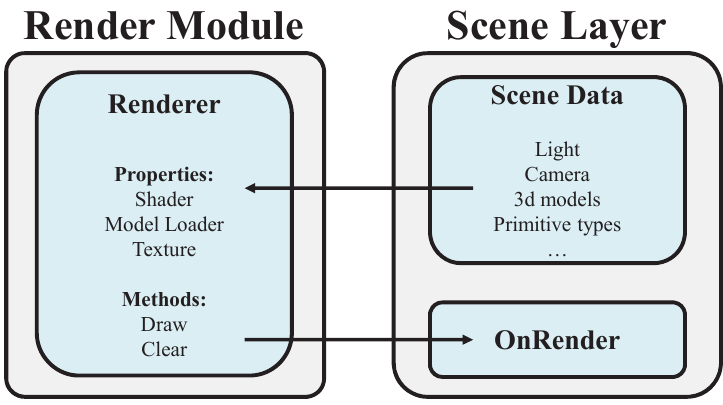
Figure 2. The rendering module.